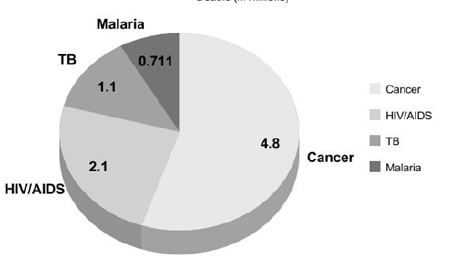
Figure 2. Deaths due to cancer, HIV/AIDS, tuberculosis (TB), and malaria in the developing world. Cancer kills more people worldwide than HIV/AIDS, TB, and malaria combined